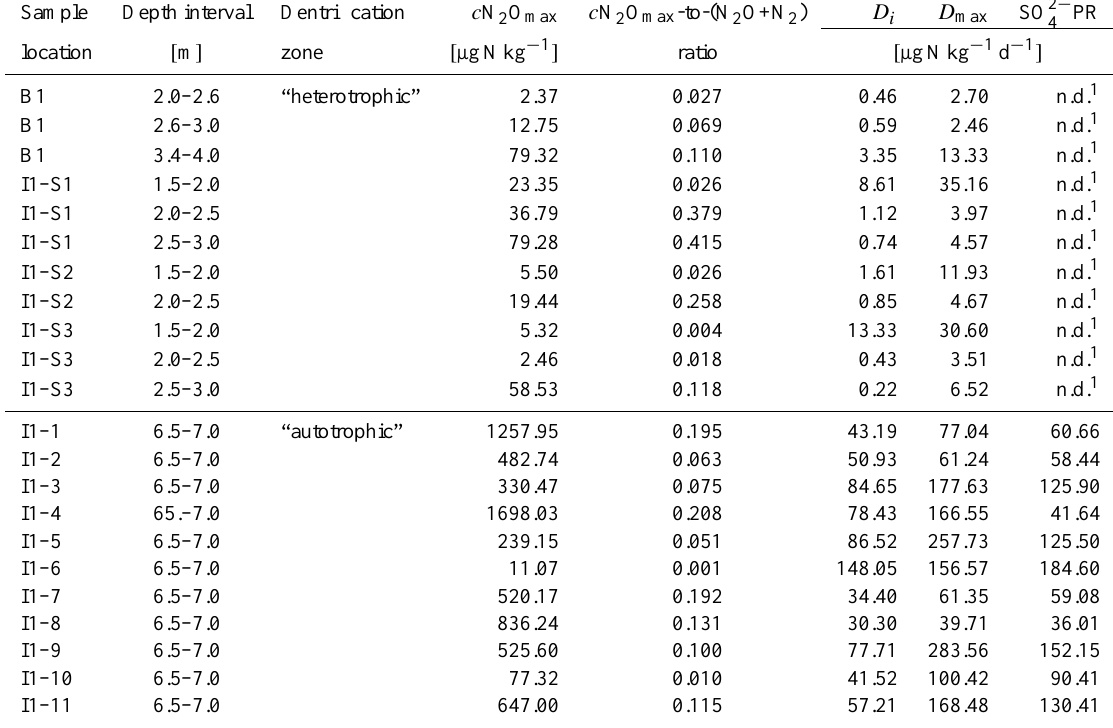
Table 2. Maximum N 2 O concentrations (cN 2 O max ), cN 2 O max -to-(N 2 O+N 2 ) ratio, and reaction rates ( D i , D max , SO 2 − obic incubation. D i denotes the initial denitrification rate calculated at day 7. D max is the maximum denitrification rate calculated for the time interval with the steepest increase of the (N 2 O+N 2 ) curve. SO 2 − from the autotrophic denitrification zone in N